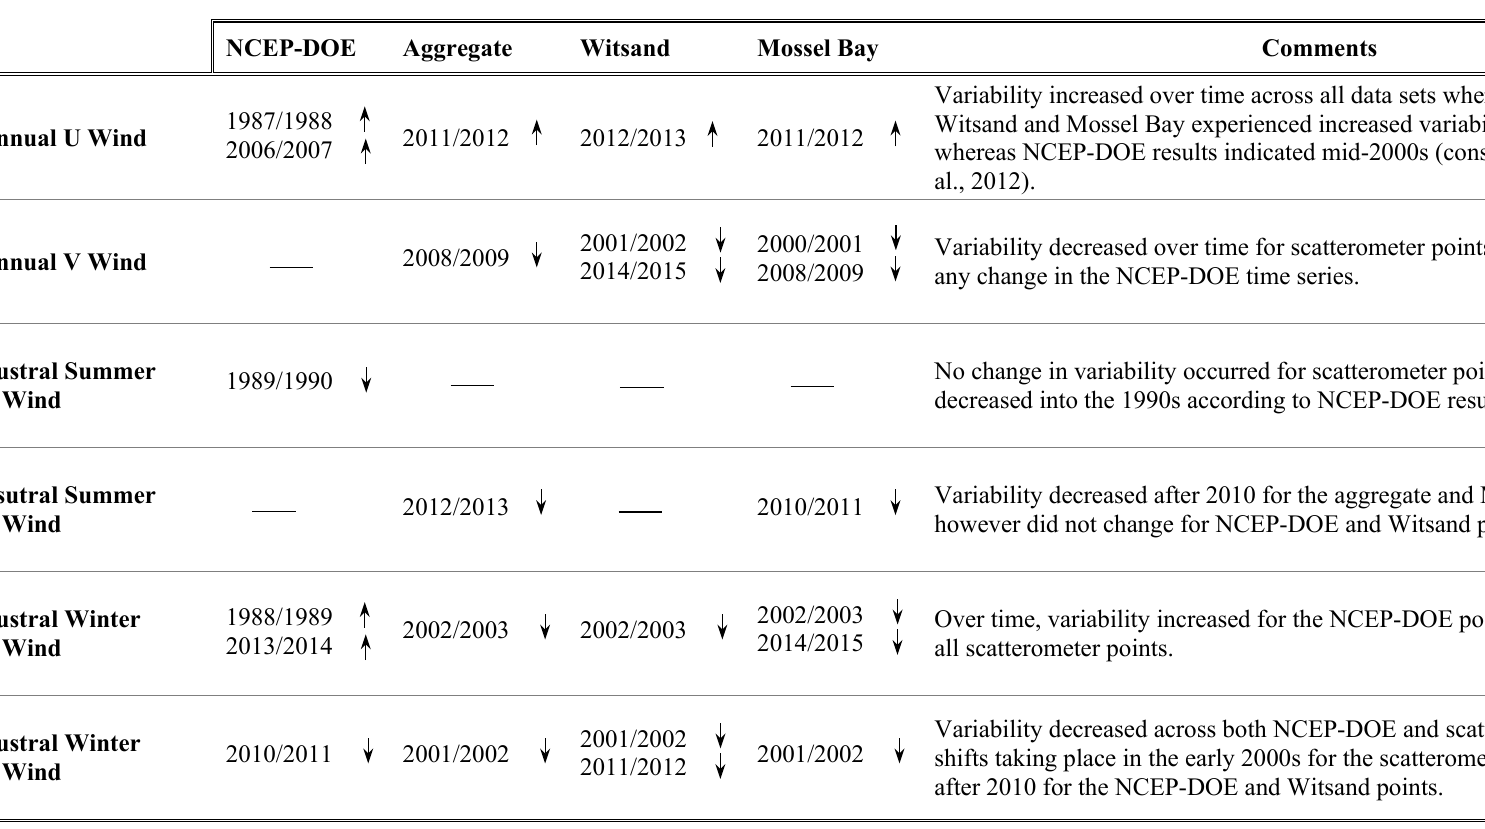
Table A5.3: Wind regime patterns for annual and austral seasons between near- and off-shore time series analysing